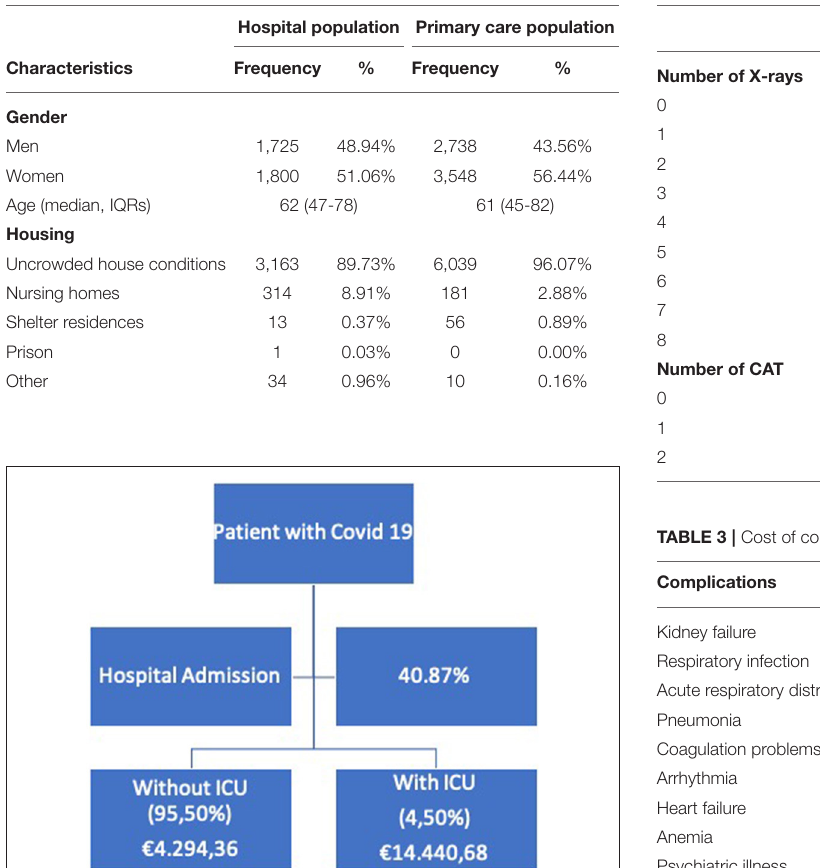
TABLE 1 | Demographic characteristics of both cohorts.